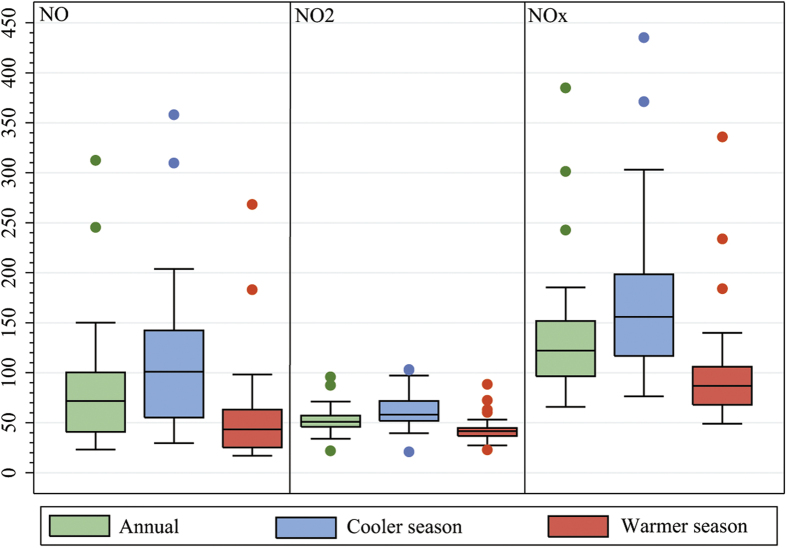
Distribution of pollutant concentrations (ppb) over the 23 monitoring stations in Tehran, Iran, 2010.The figure is generated using STATA 13 (STATA Corp., TX, USA, http://www.stata.com/).